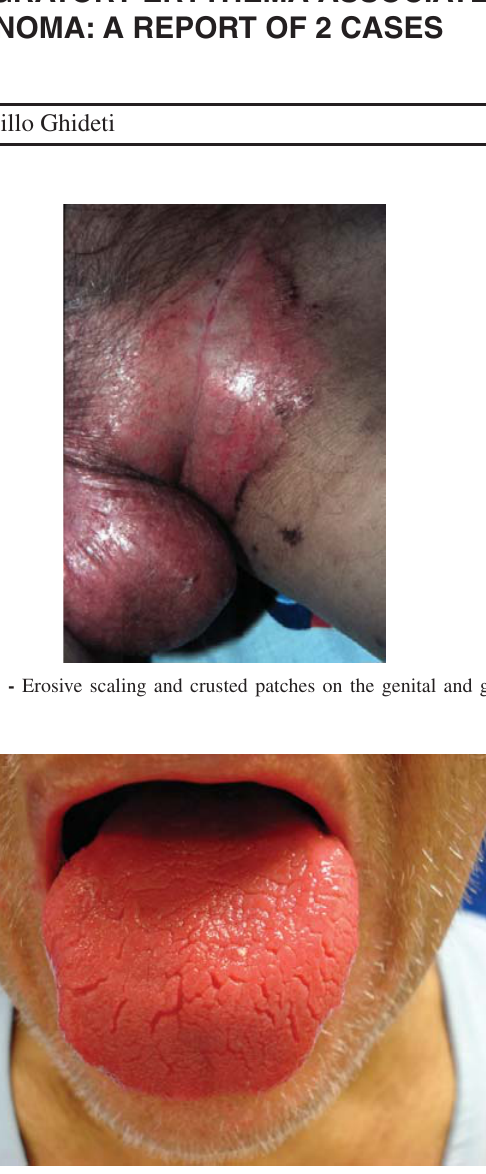
Figure 2 - Angular cheilitis and a depapilated bright red